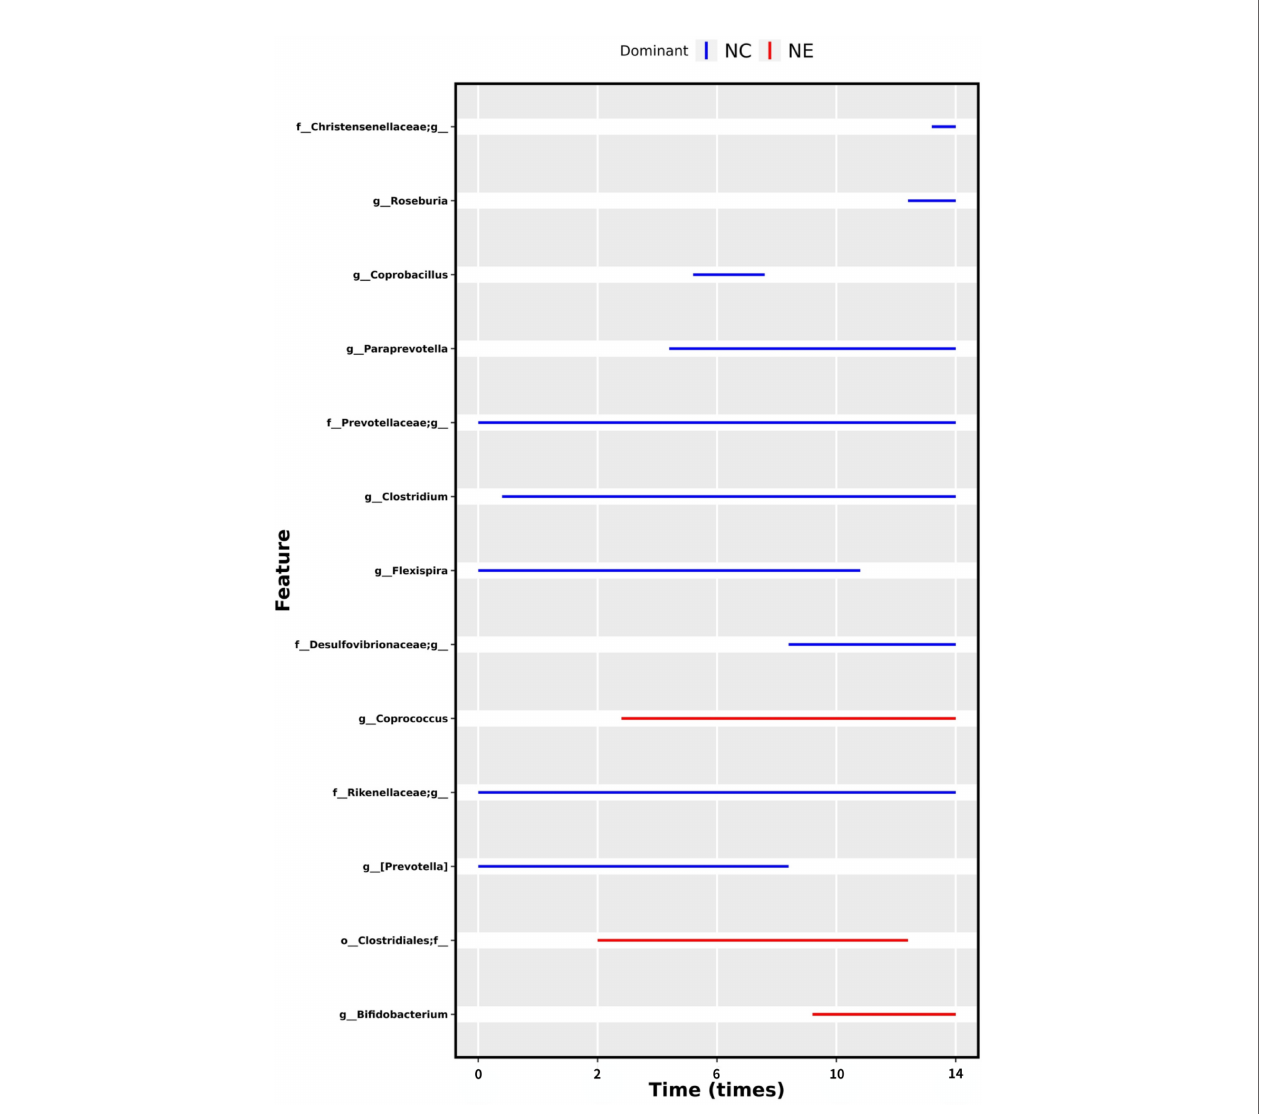
FIGURE 11 | Differential bacteria under time series grouping. The time intervals of the mutually differentially abundant genera from NC and NE groups identi fi ed by MetaLonDA. Each line represents signi fi cant time interval of the corresponding bacteria. The blue lines represent the intervals where samples from the NC group have more reads, while the red lines represent the differential abundance intervals where samples from the NE group have more reads. The bacteria names are shown on the left, and the time is shown